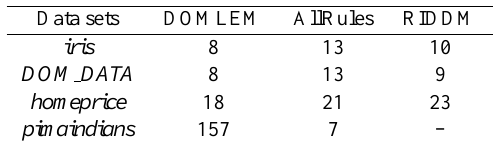
Table 3. The number of generated rules by non-incremental al- gorithms on real data